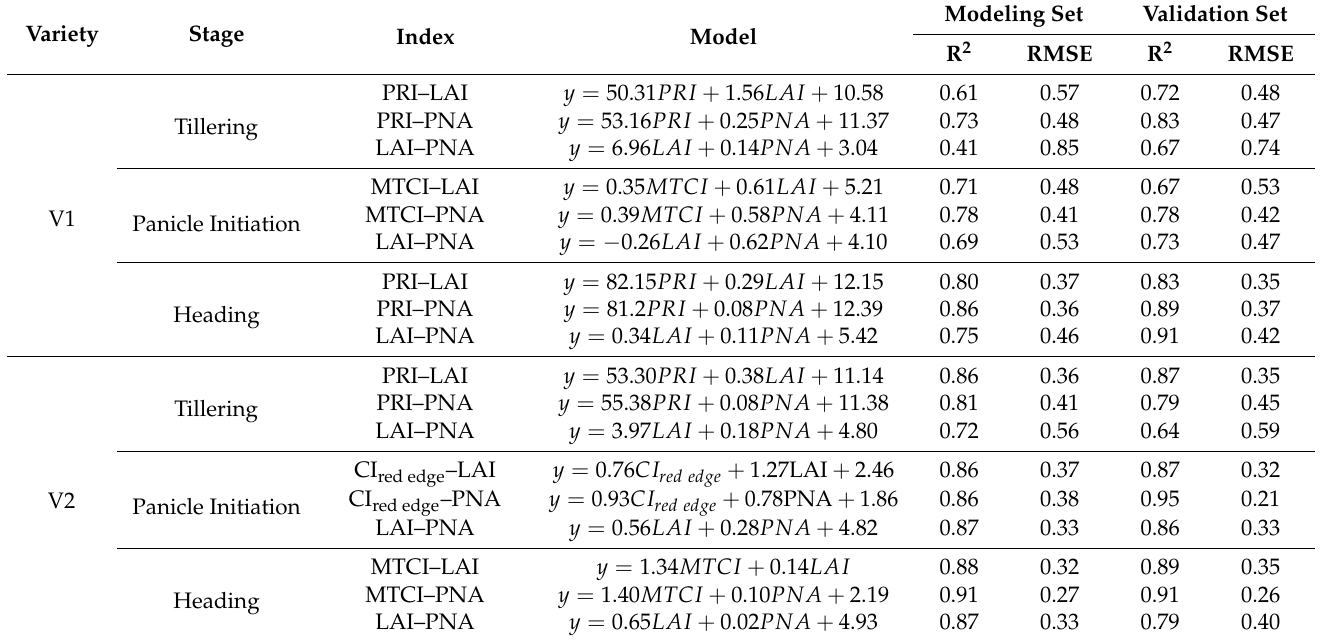
Table A1. Two-factor multiple linear regression rice grain protein content (GPC) estimation models and their accuracy ( n = 15).